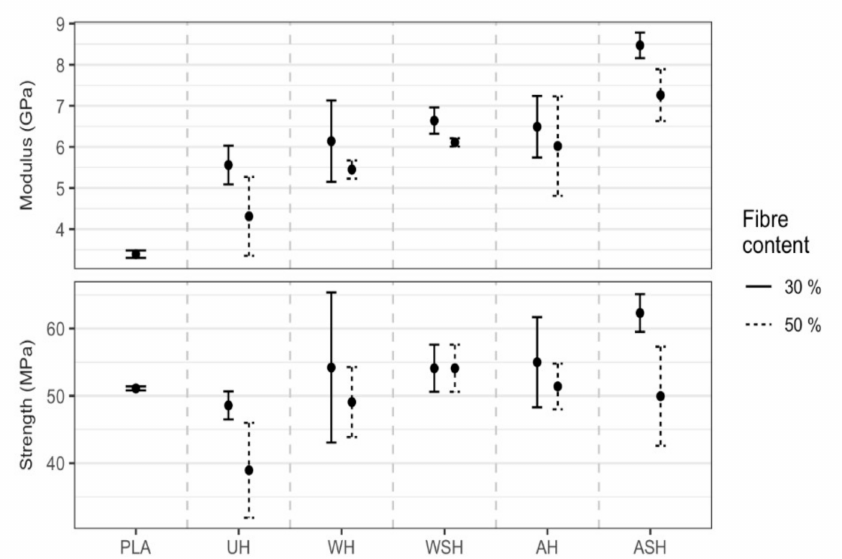
Figure 11. Medians ( • ) for YM and TS at 30 and 50 wt.% hemp fiber content for untreated (UH) and treated (WH, WSH, AH and ASH) compared to neat PLA (bars show the one interquartile range on either side of the